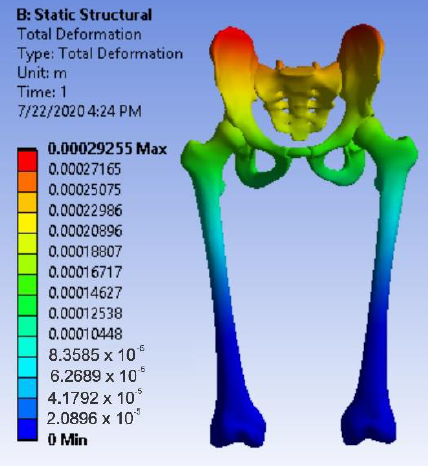
Figure 36. Displacement map for intact hip.